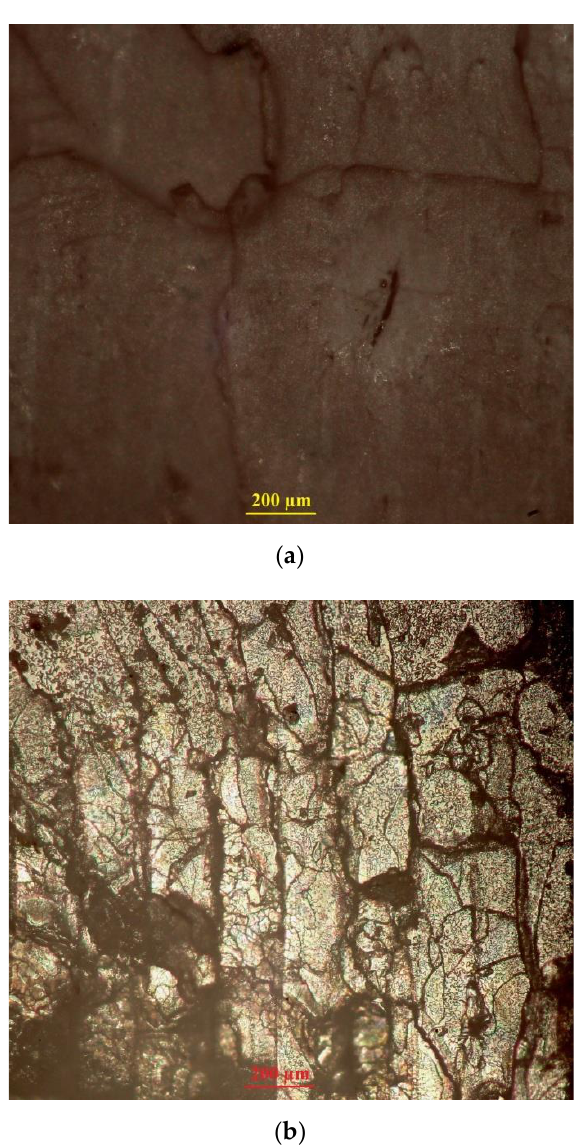
Figure 15. Optical microscopy of the cross-sectional surfaces of the FDM-printed specimens after tensile testing:( a ) fractured tensile specimens printed of ABS; ( b )fractured tensile specimens printed of PLA.